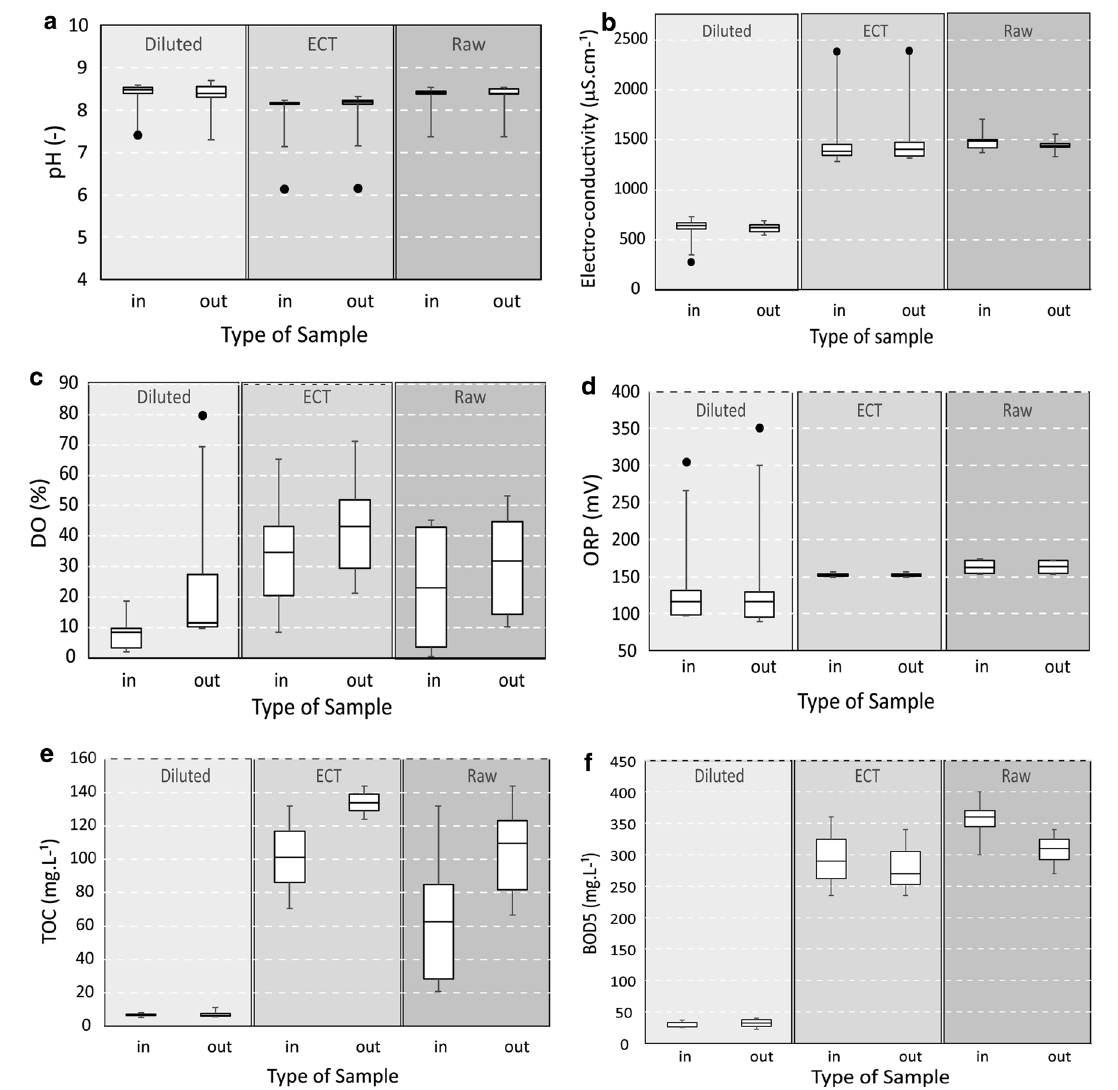
Fig. 6 Effects of the disinfection process on physical–chemical properties of